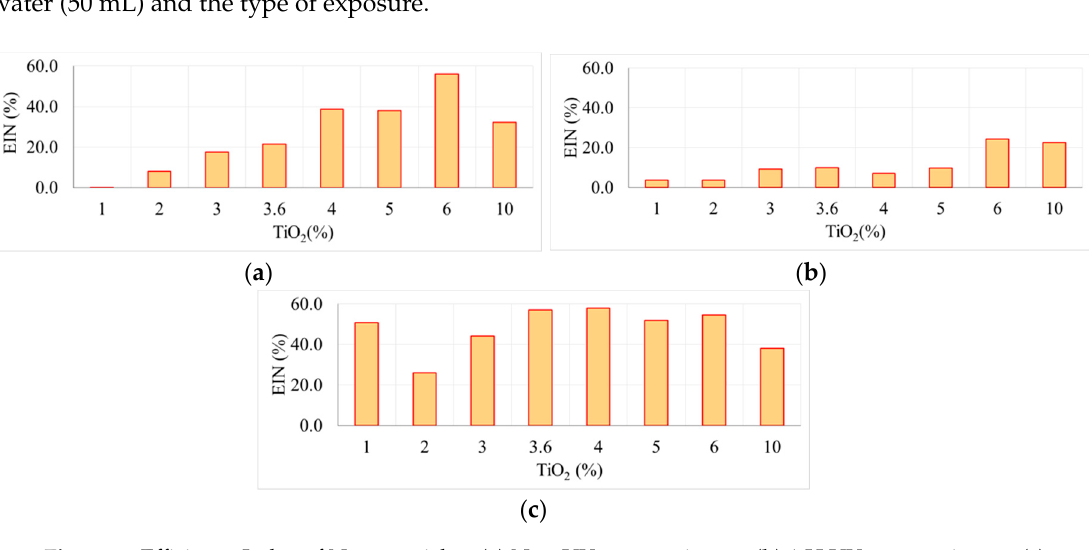
Figure 6. Surface water absorption: unexposed UV test specimens (0 UV); 1 H UV exposed test specimens (1 UV) and 1 + 24 h UV exposed test specimens (24 UV).